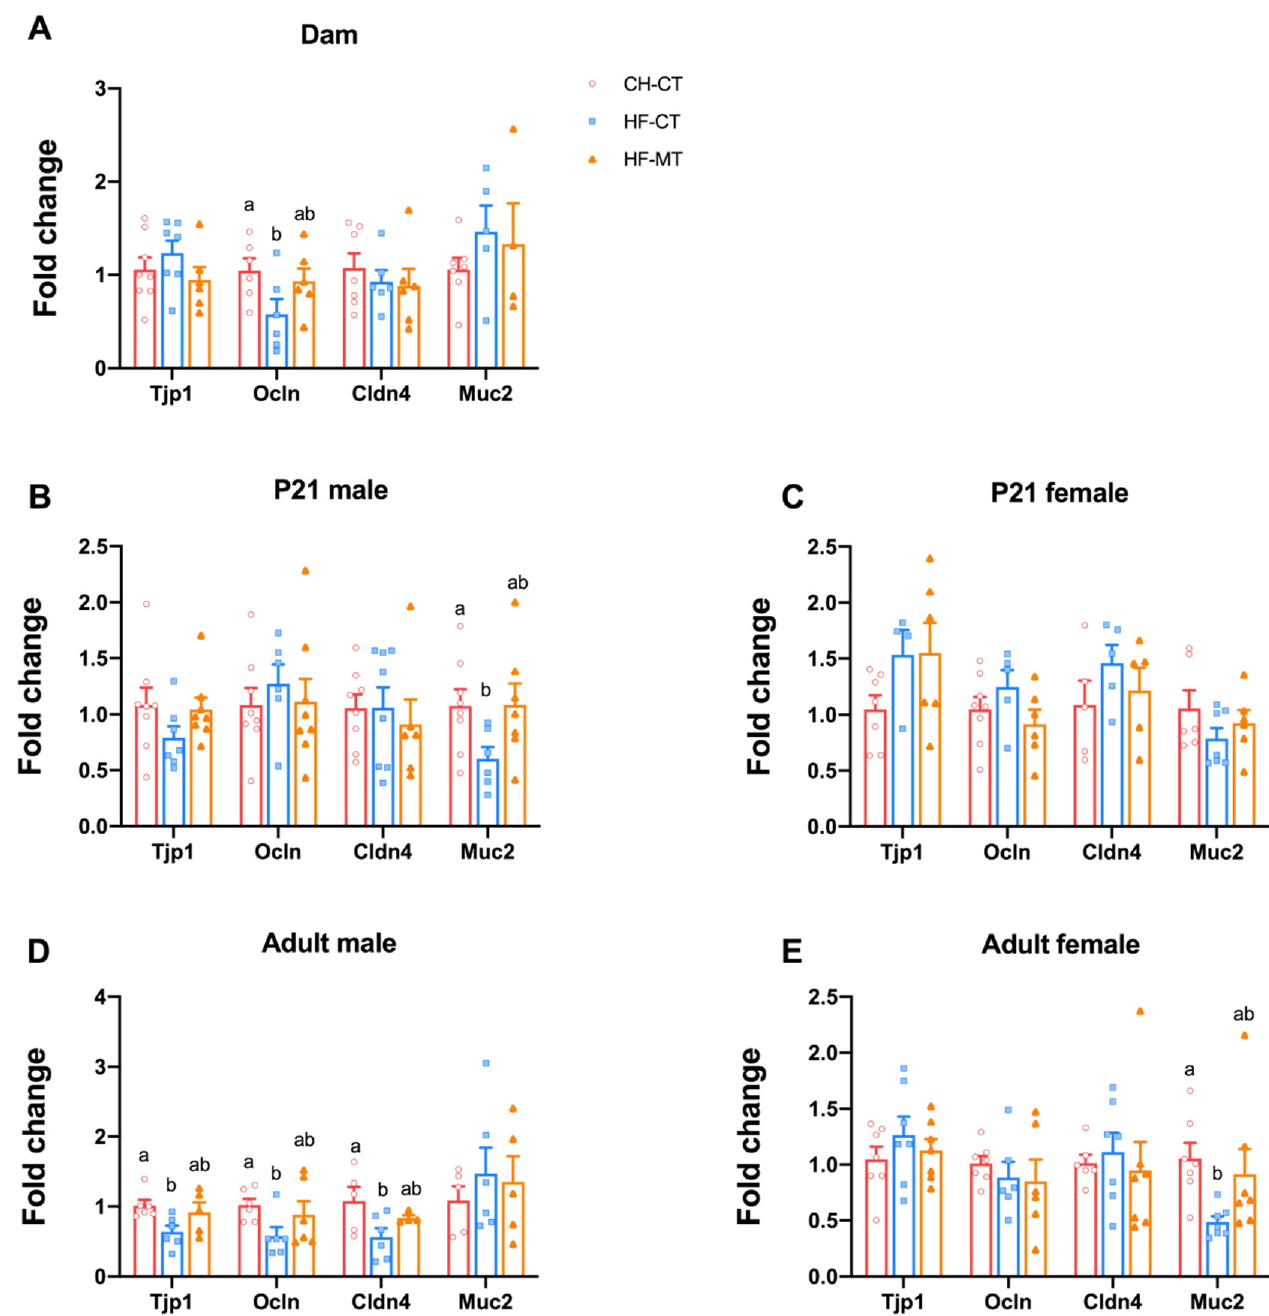
Figure 3. Maternal metformin treatment restores gut integrity in response to maternal high-fat diet in dams and offspring: ( A ) colonic mRNA expression of tight junction proteins including the tight junction protein 1 (Tjp1), occlucin (Ocln), claudin 4 (Cldn4) and mucin 2 (Muc2) in dams at weaning; ( B , C ) mRNA expression of tight junction proteins in colon of male and female offspring at weaning; ( D , E ) mRNA expression of tight junction proteins in colon of male and female offspring at 16 weeks old. Data are presented as the mean ± SEM. CH-CT, n = 6–8; HF-CT, n = 5–7; HF-MT, n = 4–7. Statistical significance was determined using one-way ANOVA with Tukey’s post hoc tests. Groups with different superscript letters differ from each other at p < 0.05 level.